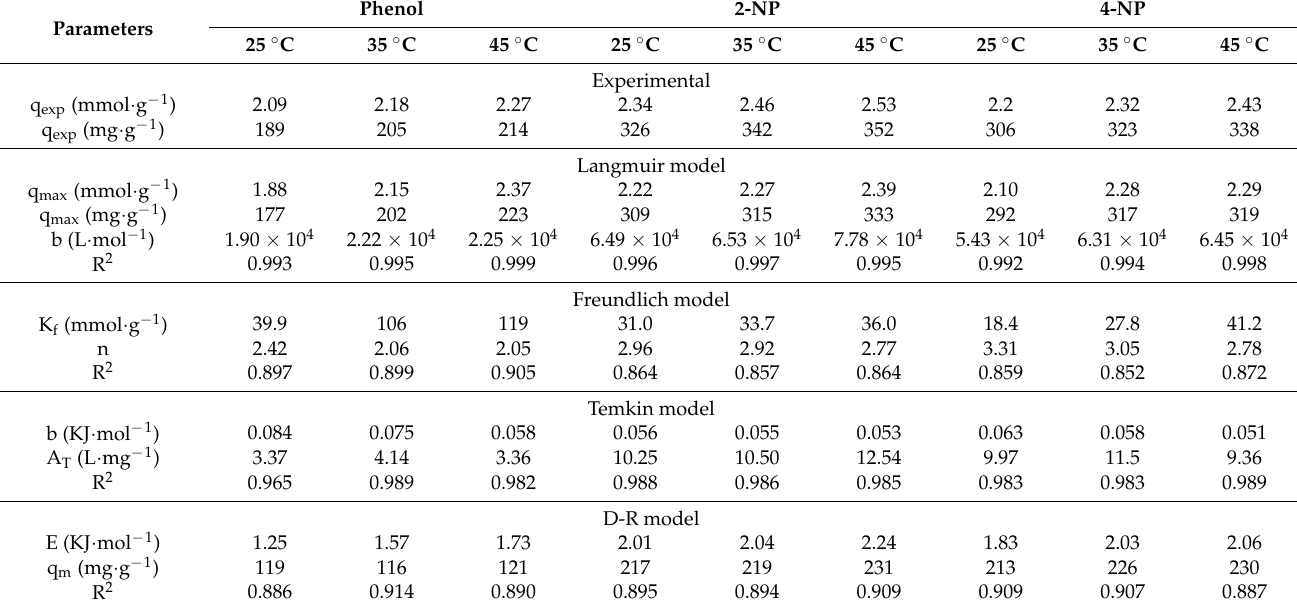
Table 1. Experimental, Langmuir, Temkin, Freundlich, and D-R isotherm adsorption values for the removal of phenol and NPs on DKLAAC at three different temperatures (25 ◦ C, 35 ◦ C, and 45 ◦